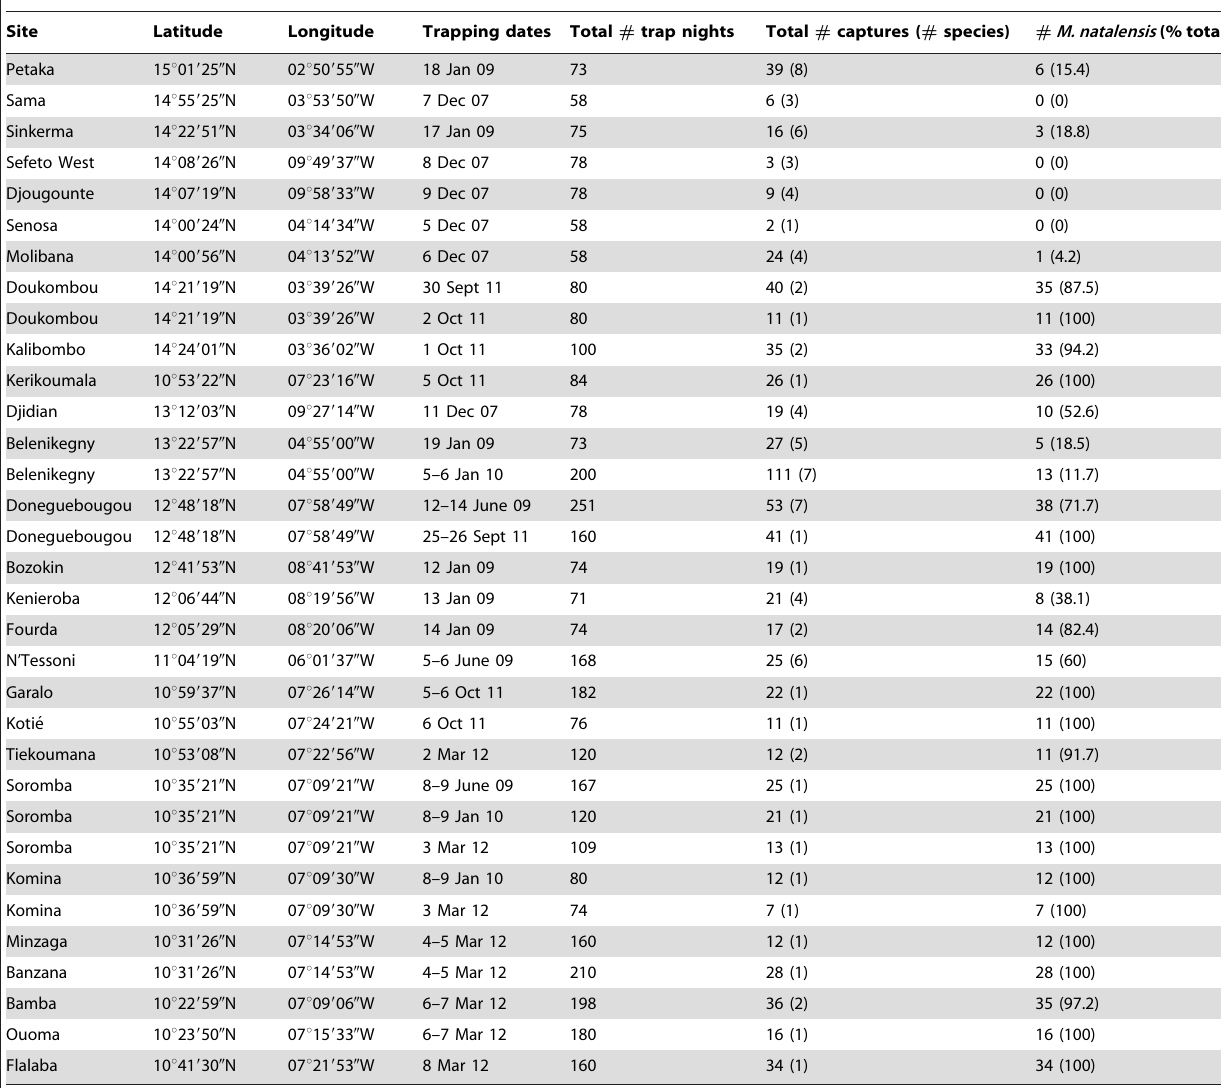
Table 1. Prevalence of Mastomys natalensis captured in various villages in sub-Saharan Mali.